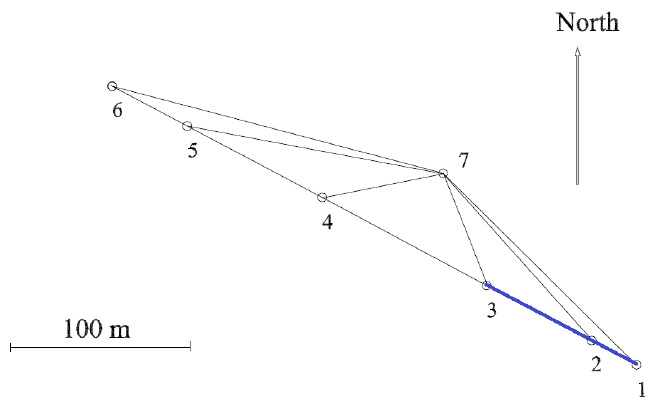
Figure 10. UPV submillimetric calibration test